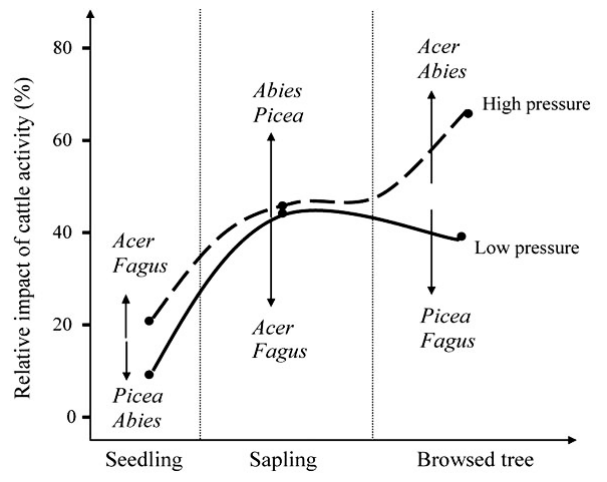
Fig. 2 . Illustrative example of nonlinearities and thresholds in a Swiss mountain wooded pasture: impact of cattle activity on seedlings (< 1 year old), saplings (1-3 years), and browsed trees (4-8 years) relative to other survival and growth limiting factors. Trees were exposed to low (solid line) and high (dotted line) grazing pressures. Arrows indicate a higher (up) or lower (down) impact of cattle, which varies by deciduous ( Acer pseudoplatanus, Fagus sylvatica ) and coniferous species, ( Picea abies and Abies alba ). The impact of grazing increases with higher development stages and high grazing pressure. In contrast, low grazing pressure reduces the relative importance once the seedlings have developed to browsed trees. Deciduous species are generally more vulnerable to cattle activity,